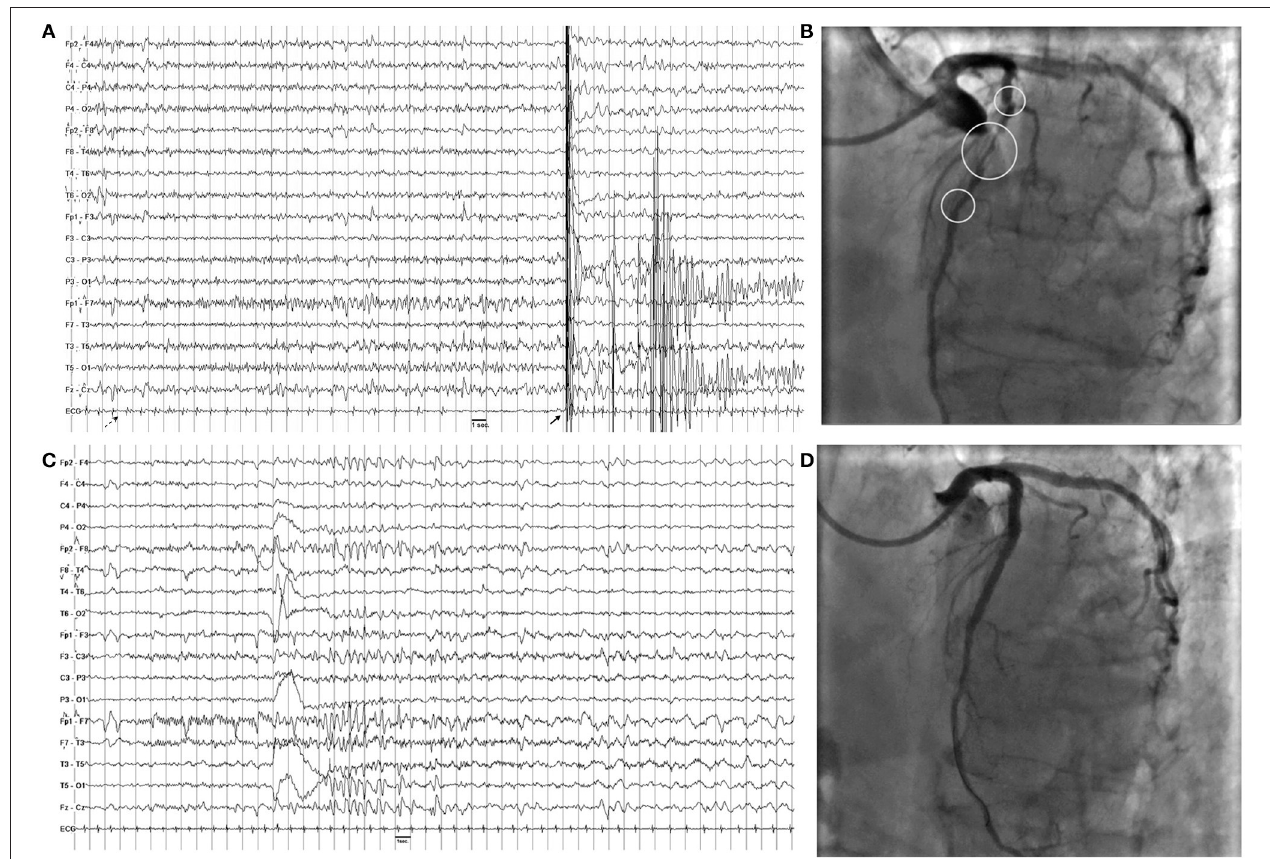
FIGURE 2 | (A) Ictal asystole. On ictal EEG recording note the diffuse electrodecrement followed by buildup of rhythmic 4–6Hz sharp activity more evident in the left temporal regions. On ECG, there is a progressive slowing of heart followed by asystole of 8s. The dashed arrow indicates seizure onset, while the full arrow indicates the artifact due to the patient’s fall from standing position. (B) Coronary angiography shows sub-occlusive stenotic traits (circles) of the left anterior descending coronary. (C) Ictal EEG after angioplasty shows a similar pattern with no modification of hearth rate on ECG channel. (D) Coronary angiography after angioplasty shows normal flow of the left anterior descending